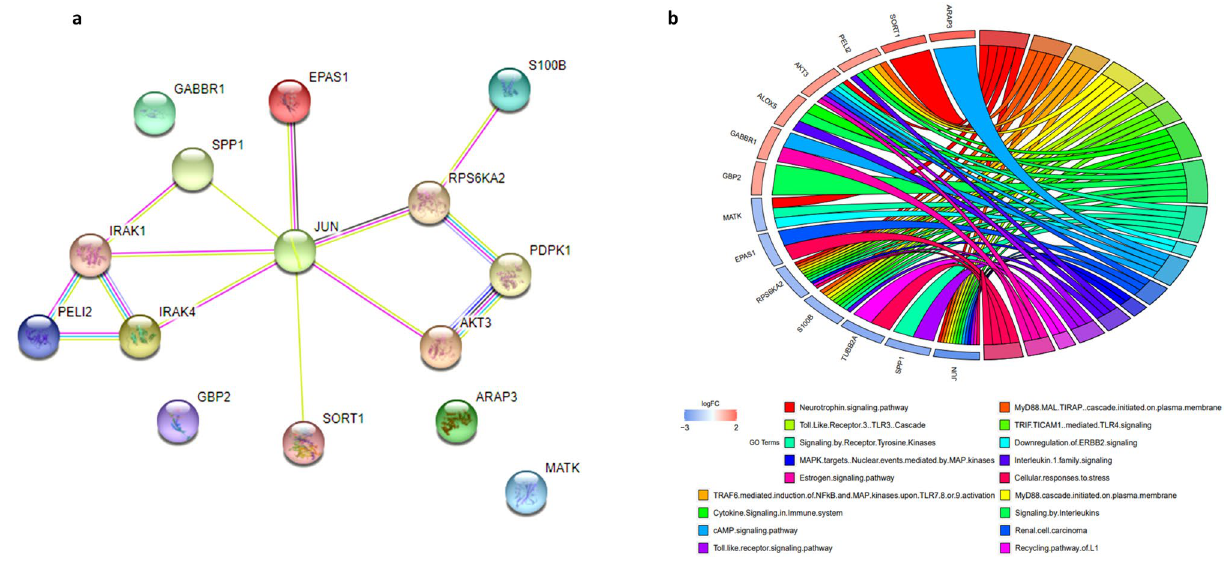
Figure 7. Pathway enrichment among AML deregulated genes associated with chemotherapeutic resistance. ( a ) Protein–protein interaction (PPI) network of dysregulated genes with more significance based on KEGG biological pathways. The protein–protein association network was retrieved from the STRING enrichment web service (https:// string- db. org/) using the StringApp in the Cytoscape v3.7.0 (https:// cytos cape. org/) and additional interactors were added. ( b ) Circos diagram depicts KEGG (https:// www. kegg. jp/ kegg/ kegg1. html) and Reactome (https:// react ome. org/) signaling pathways enriched for DEGs with probable contribution to